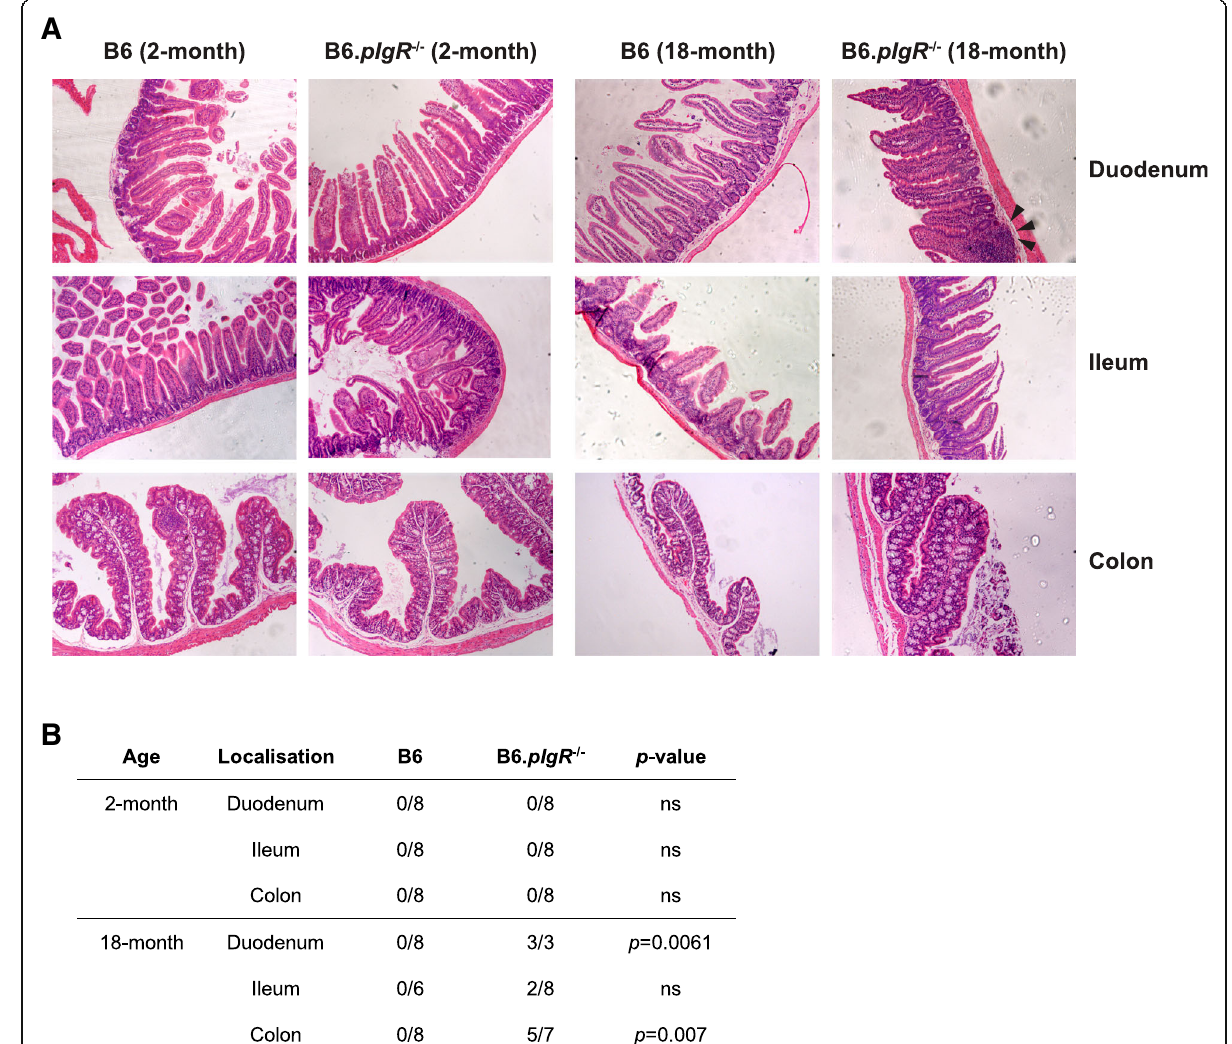
Fig. 1 Age-dependent immunopathology in the GIT of pIgR − / − mice. a Intestine sections of 2-month and 18-month old male B6 and pIgR − / −